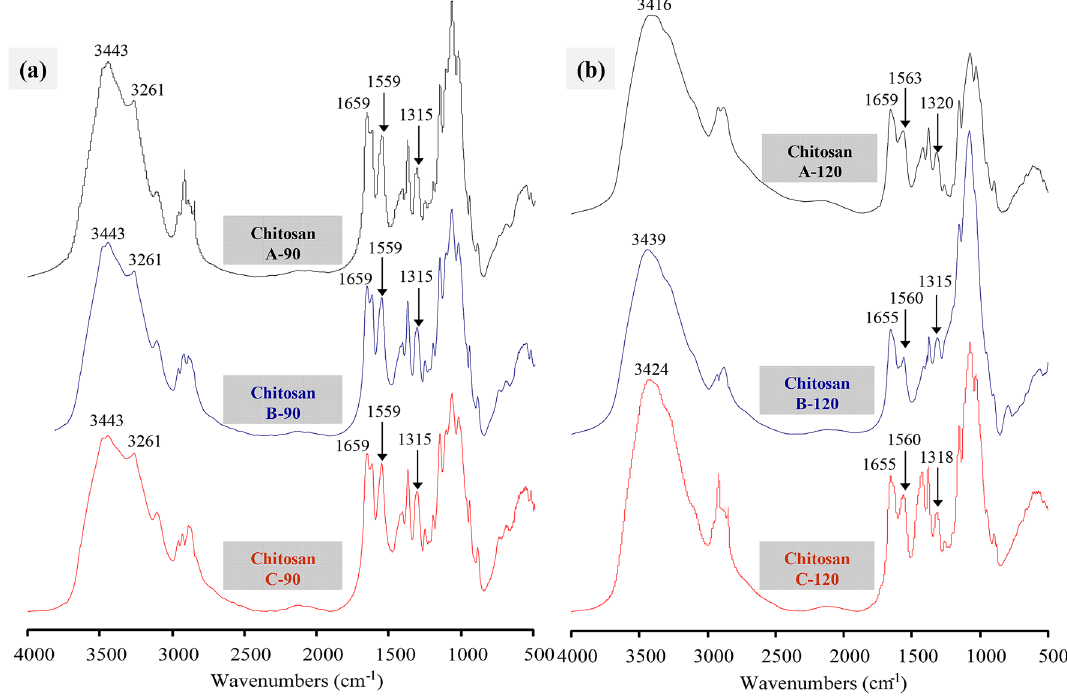
Figure 2. FTIR spectra of crab shell chitosan by deacetylation at 90 °C ( a ) and 120 °C ( b